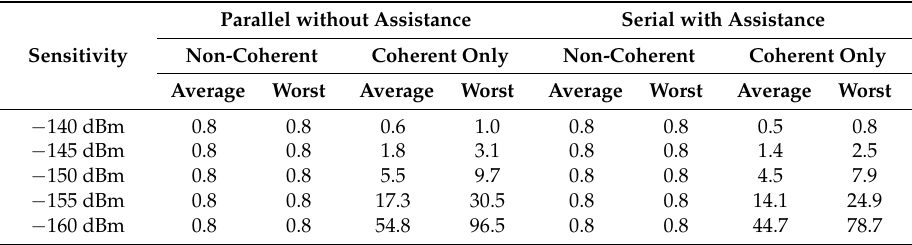
Table 11. Ratio of number of frequency bins between the L5 and L1 C/A